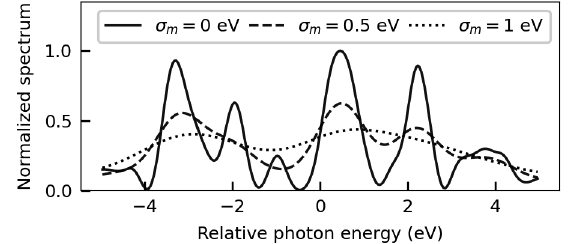
FIG. 5. A typical single-shot spectrum from 1D simulations at z ¼ 40 m showing the impact of 0-, 0.5-, and 1.0-eV measure- ment resolution.